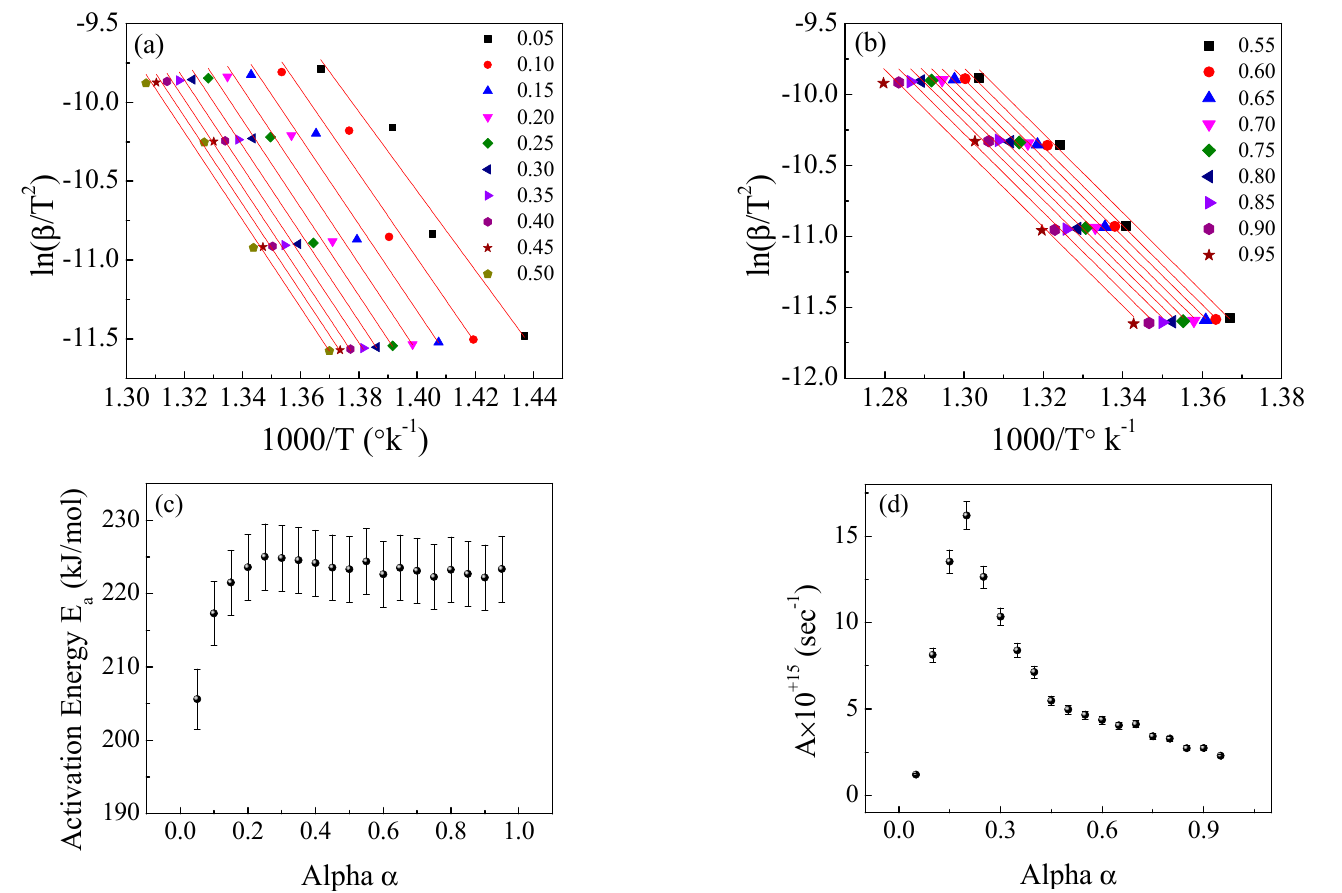
deviation (0.64, 0.53, and 3.31, respectively). The average activation energy for each method is close to those of the Kissinger and Augis–Bennett methods, with a slight difference not exceeding 5%, as shown in Table